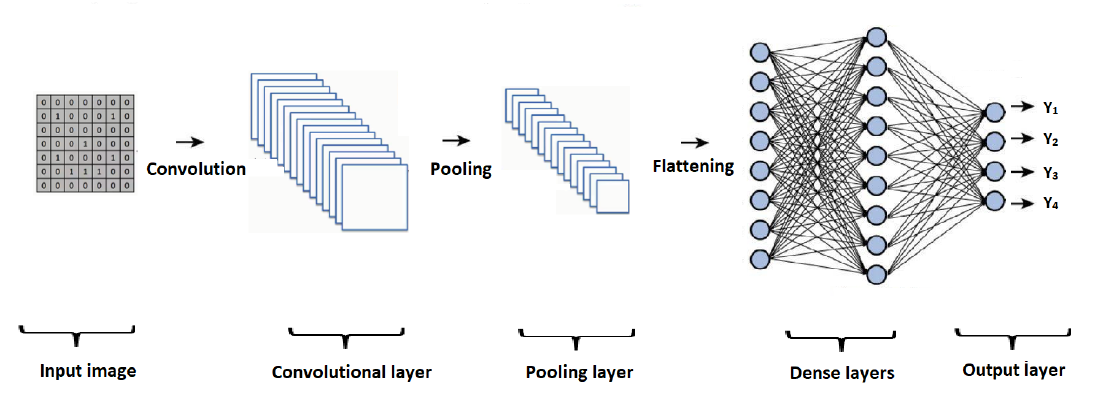
Figure 2. Representation of the architecture of a convolutional neural network (CNN).